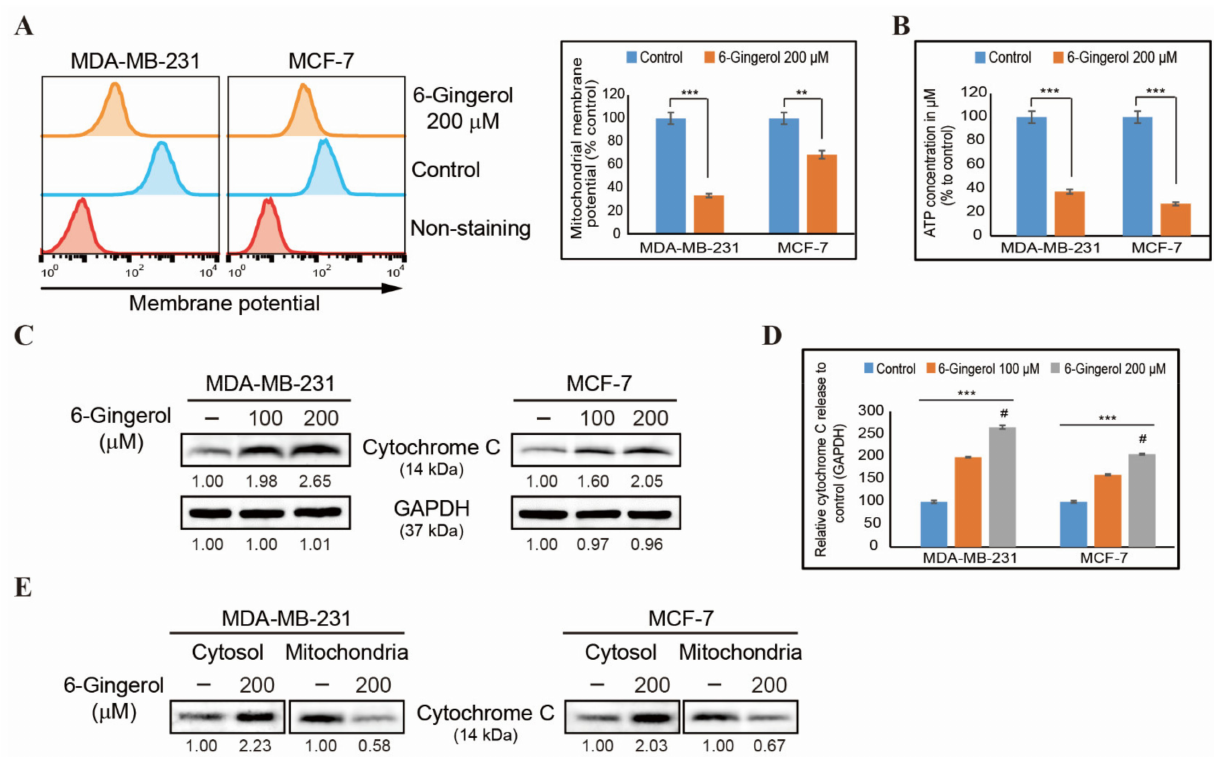
Figure 5. 6-Gingerol induces the release of cytochrome c. ( A ) Flow cytometry analysis in MDA-MB-231 and MCF-7 cells after treatment with 6-gingerol for 48 h showing mitochondrial membrane potential and the resulting decrease in membrane potential. The values are presented as means ± SEM of three independent experiments performed in triplicate (n = 3). ** p < 0.01 and *** p < 0.001 (Student’s t -test). ( B ) Graphical representation of ATP formation induced by treatment with 200 µ M of 6-gingerol in breast cancer cells. The values are presented as means ± SEM of three independent experiments performed in triplicate (n = 3). *** p < 0.001 (Student’s t -test). ( C ) Western blotting of MDA-MB-231 and MCF-7 cells after 48 h treatment with 100 and 200 µ M of 6-gingerol showing the expression of cytochrome c. ( D ) Representative expression of proteins was determined by densitometry and normalized to GAPDH. Controls are set to 100. Data were confirmed after repeating the experiment three times. *** p < 0.001 (ANOVA test). # p < 0.001 vs. control. ( E ) Western blotting analysis in cytosolic and mitochondrial fractions isolated from MDA-MB-231 and MCF-7 cells after 48 h treatment with 200 µ M of 6-gingerol showing the expression of cytochrome c